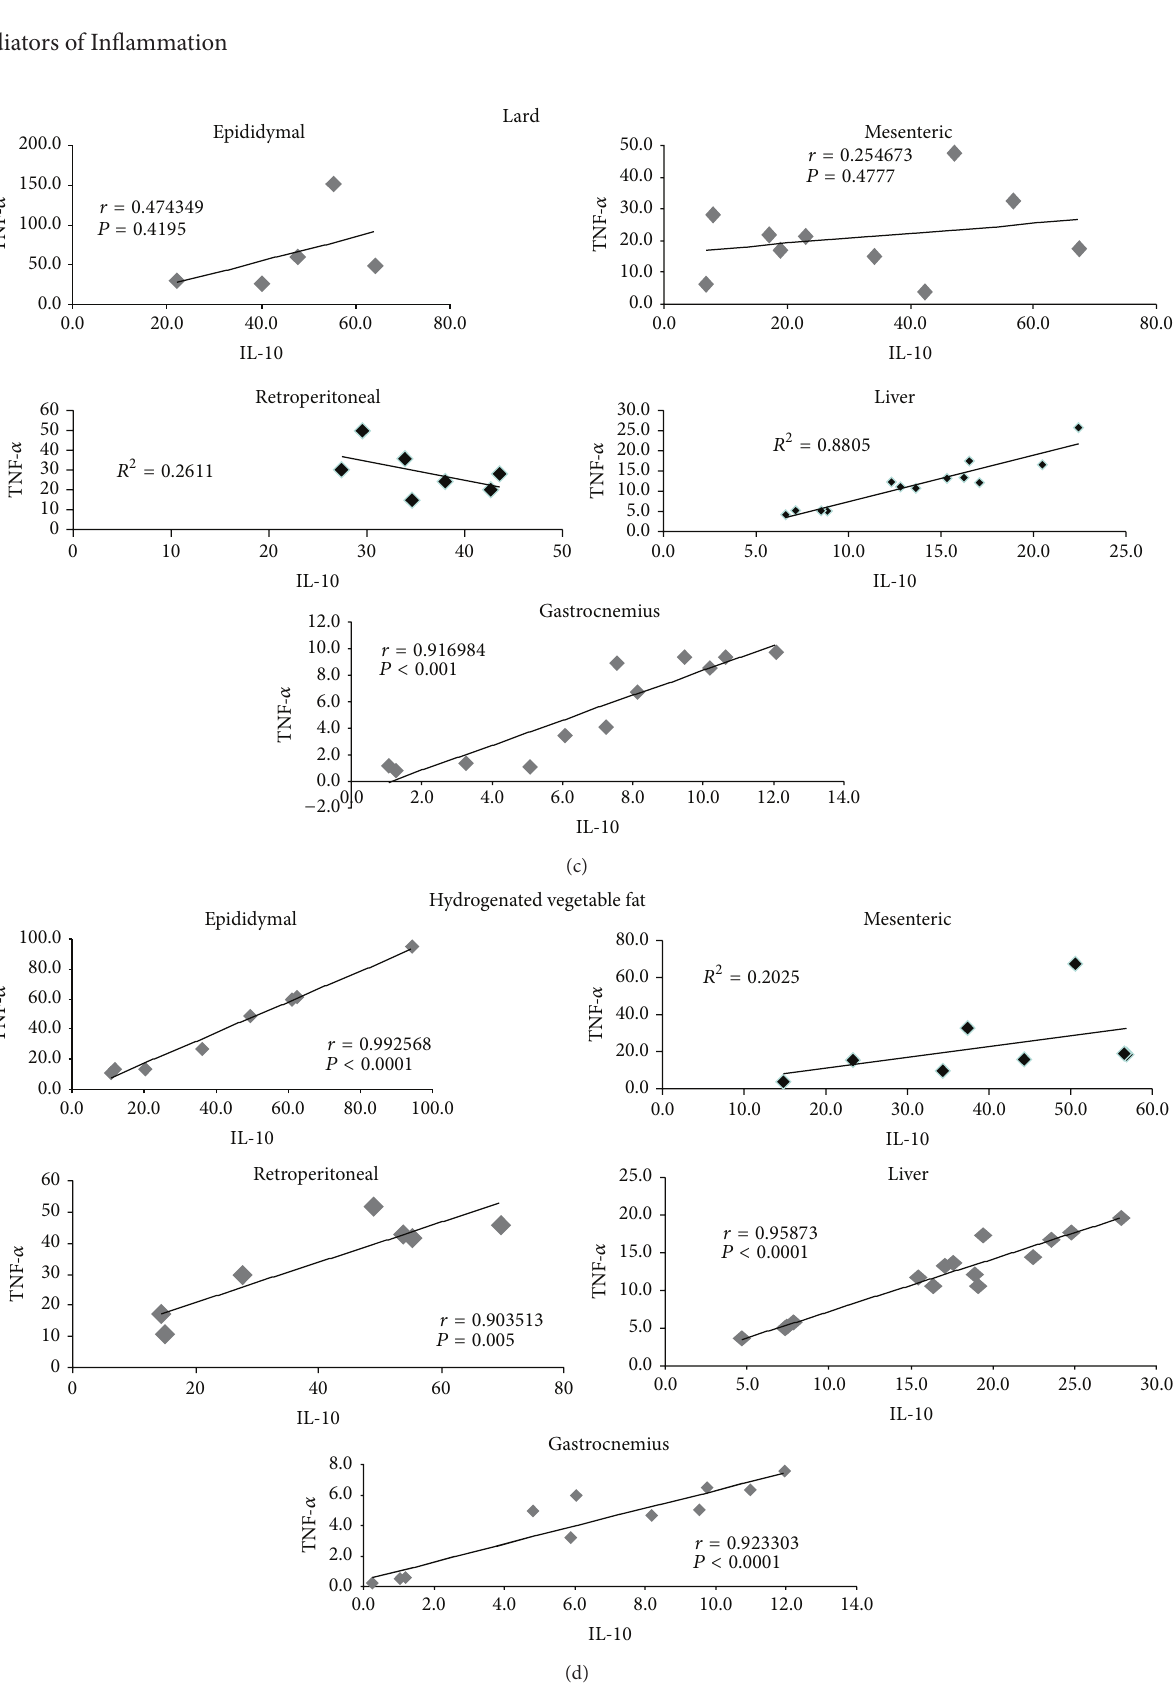
Figure 2: Correlation between cytokines (IL-10 and TNF- 𝛼 ) in adipose tissue depots, liver, and gastrocnemius muscle of studied mice groups—(C) control group, (S) soybean, (L) lard, and (H) hydrogenated vegetable fat groups. (Number of samples from 5 to 12